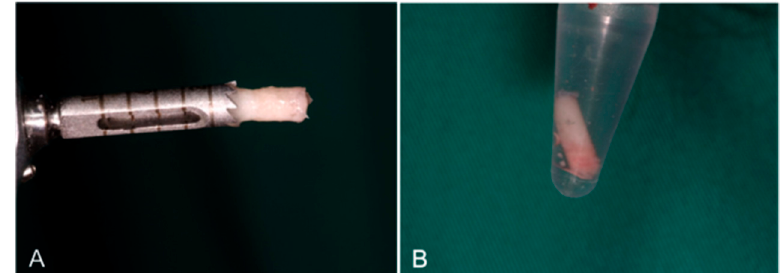
Figure 11. ( A ) A sample of bone core for histomorphometric analysis; ( B ) Sixty bone biopsies were obtained from sixty grafted sites.